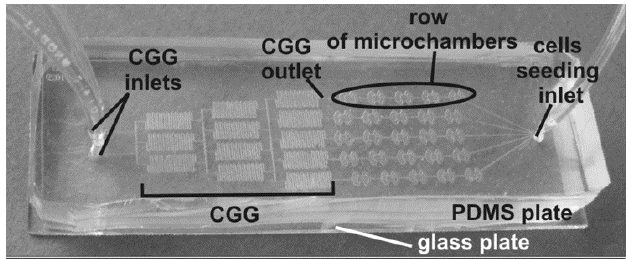
Figure 2. Tree-like shape concentration gradient generator provides five different drug concentrations into the microchambers [79].